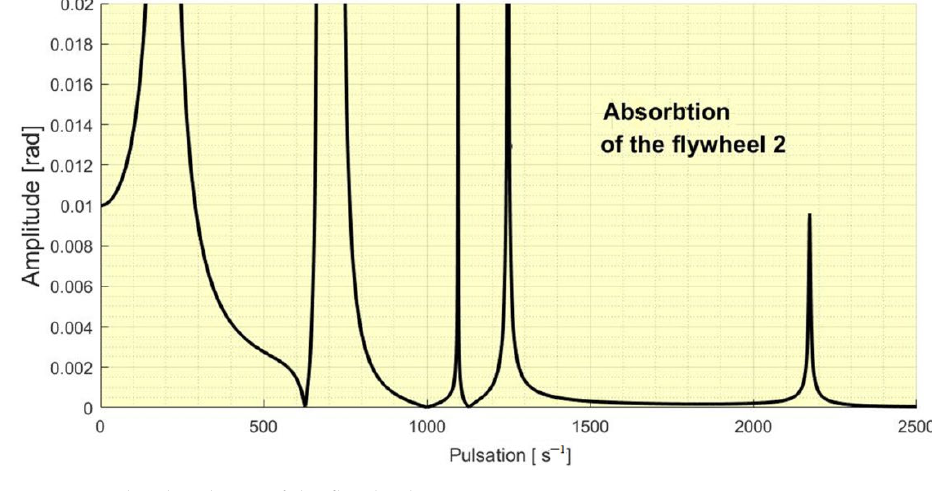
Figure 7. The absorbtion of the flywheel 2.